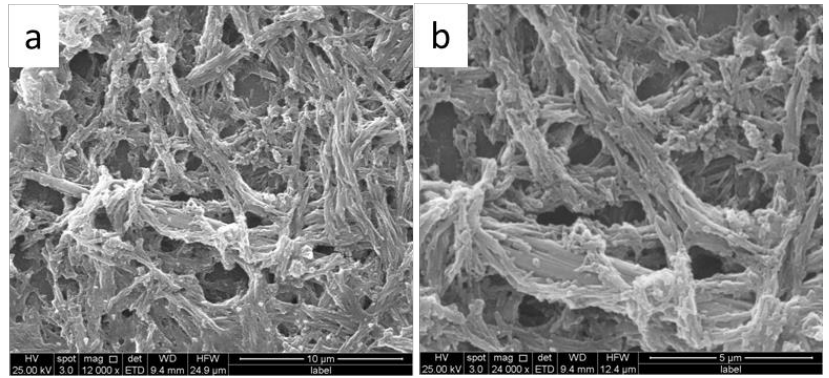
Figure 5. The SEM images of the gel after α-amylase processing ([NPPD] = 10 −3 mol/L, [α-CD] = 10 −3 mol/L, [RF] = 2 × 10 −3 mol/L, [α-amylase] = 0.01 U·mL −1 ), ( a ) the xerogels after α-amylase processing in a mixed solution for a larger scale; ( b ) For hydrogel in a mixed solution in a small scale.